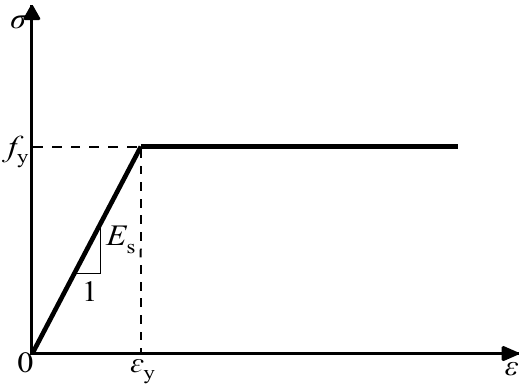
Figure 3. Stress–strain curves of steel.